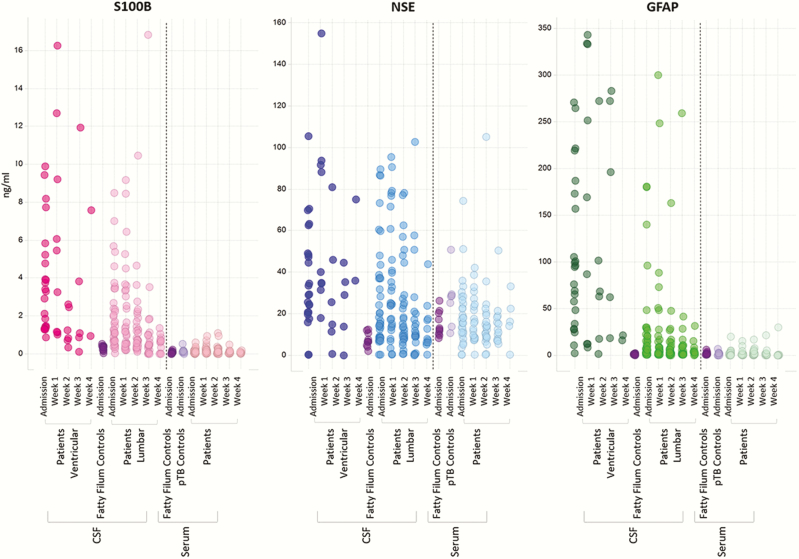
Neuromarker concentrations for cases over time. Concentrations (ng/ml) for neuromarkers S100B, NSE and GFAP in ventricular CSF, lumbar CSF and serum are plotted from admission to week 4 for all TBM cases. Ventricular samples from week 4 represent only 2 patients – the elevated concentrations belonged to a patient who had failed medical treatment for their hydrocephalus and required a ventriculo-peritoneal shunt. Concentrations for fatty filum and pulmonary TB (pTB) controls are also shown.